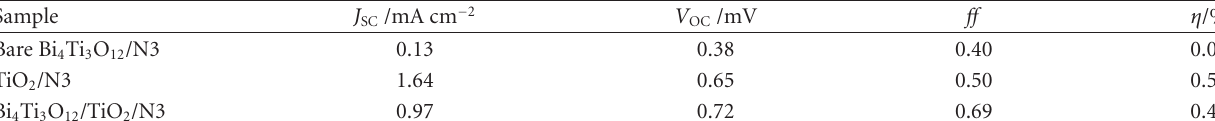
Table 1: Photoelectrochemical parameters of DSSCs using bare and 5 at % TiO 2 -modified Bi 4 Ti 3 O 12 nanoporous electrodes.